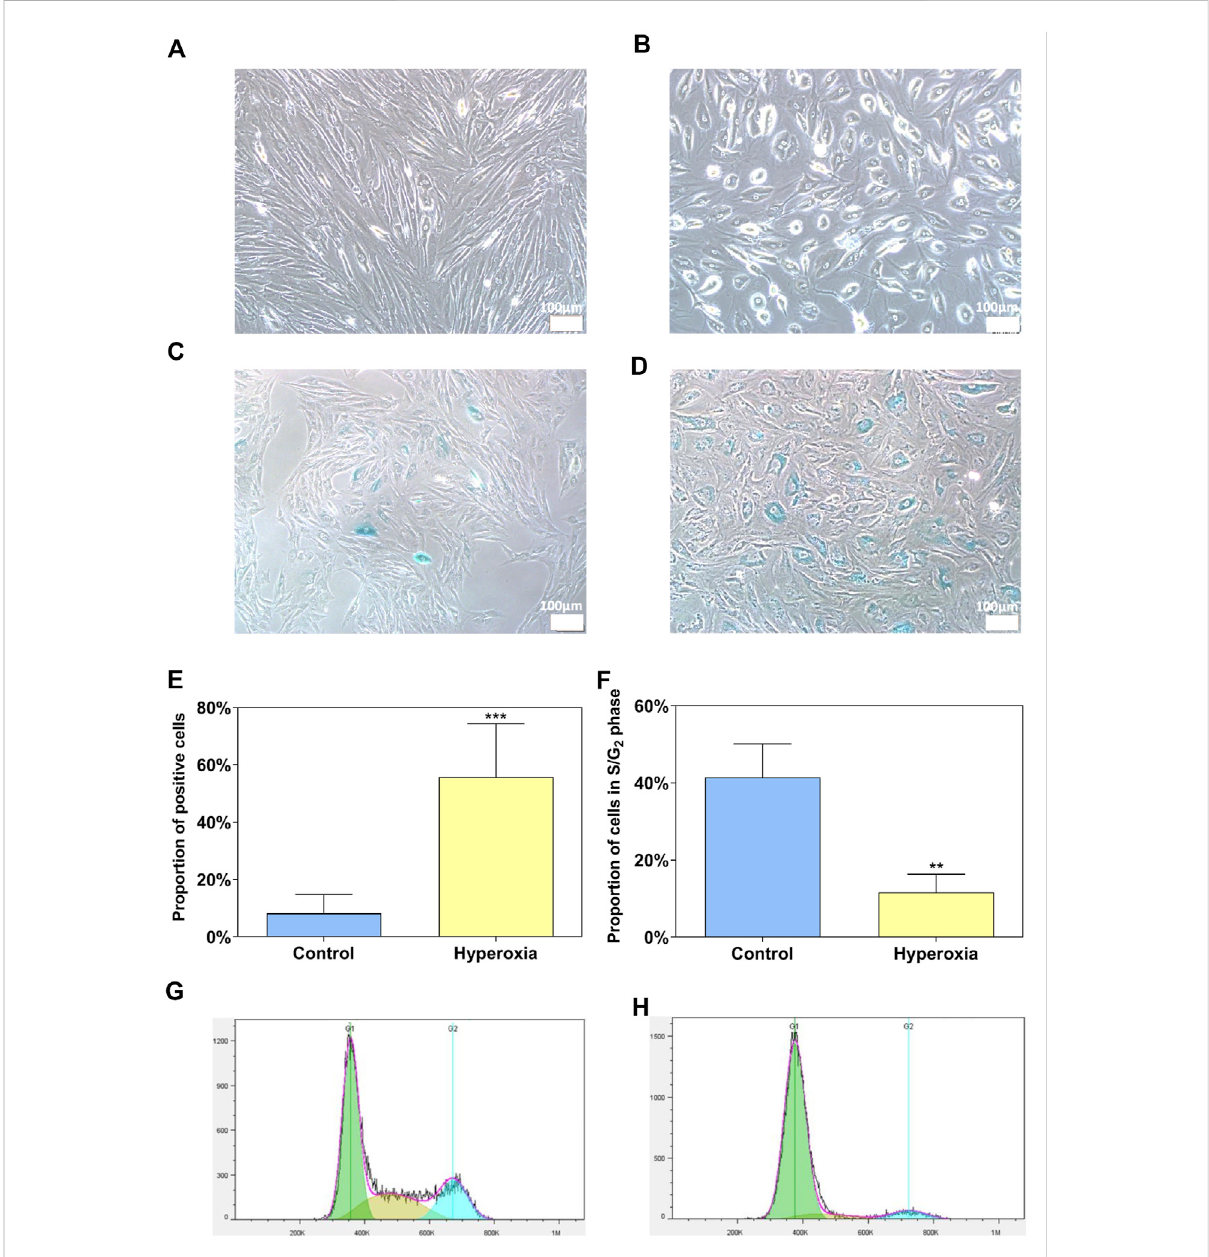
FIGURE 1 Hyperoxia as an experimental model of senescence for porcine trabecular meshwork (PTM) cells. Morphology of PTM cells grown for 2 weeks under control (A) or hyperoxic (40% O 2 )conditions (B) . β -galactosidase staining of PTM cells grown for 2 weeks undercontrol (C) or hyperoxic (40% O 2 )conditions (D) .PTM cellsgrown underthecontrol conditionsexhibitednegligiblestainingfor senescencemarker β -galactosidase, whereas cells exposed to hyperoxia stained positive for this marker (E) (*** p < 0.001). The proportion of cells in the S phase and G2 phase decreased after hyperoxia exposure compared with thecontrol group (F) (** p < 0.01). Flow cytometryquanti fi cation ofthecell cycleof PTM cells grown for 2 weeks under control (G) or hyperoxic (40% O 2 ) conditions (H)